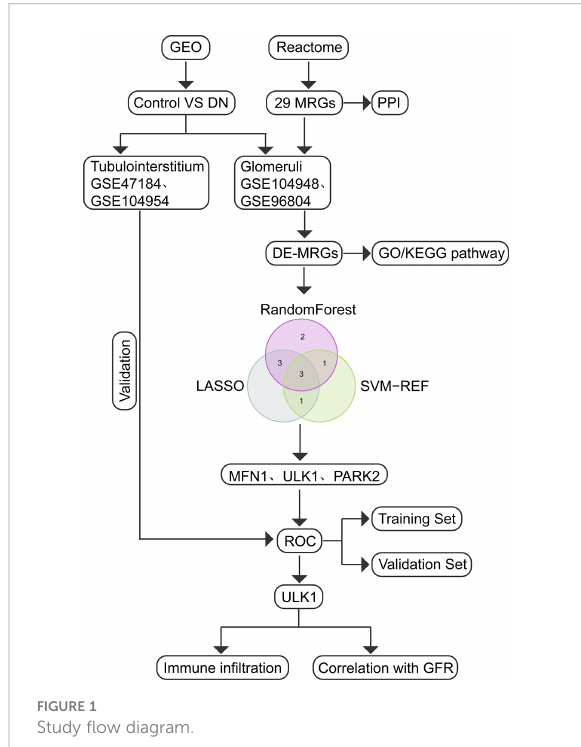
FIGURE 1 Study fl ow